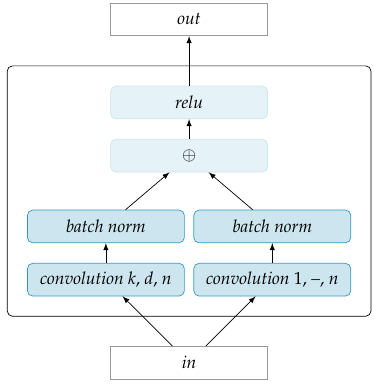
Figure 3. Dilated residual